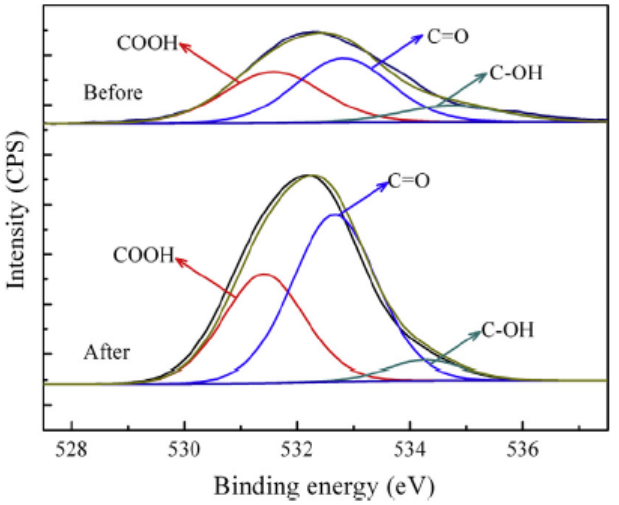
Figure 5. X-ray photoelectron spectroscopy (XPS) spectra of graphite nanosheet before and after supercritical water. Data obtained from [8].